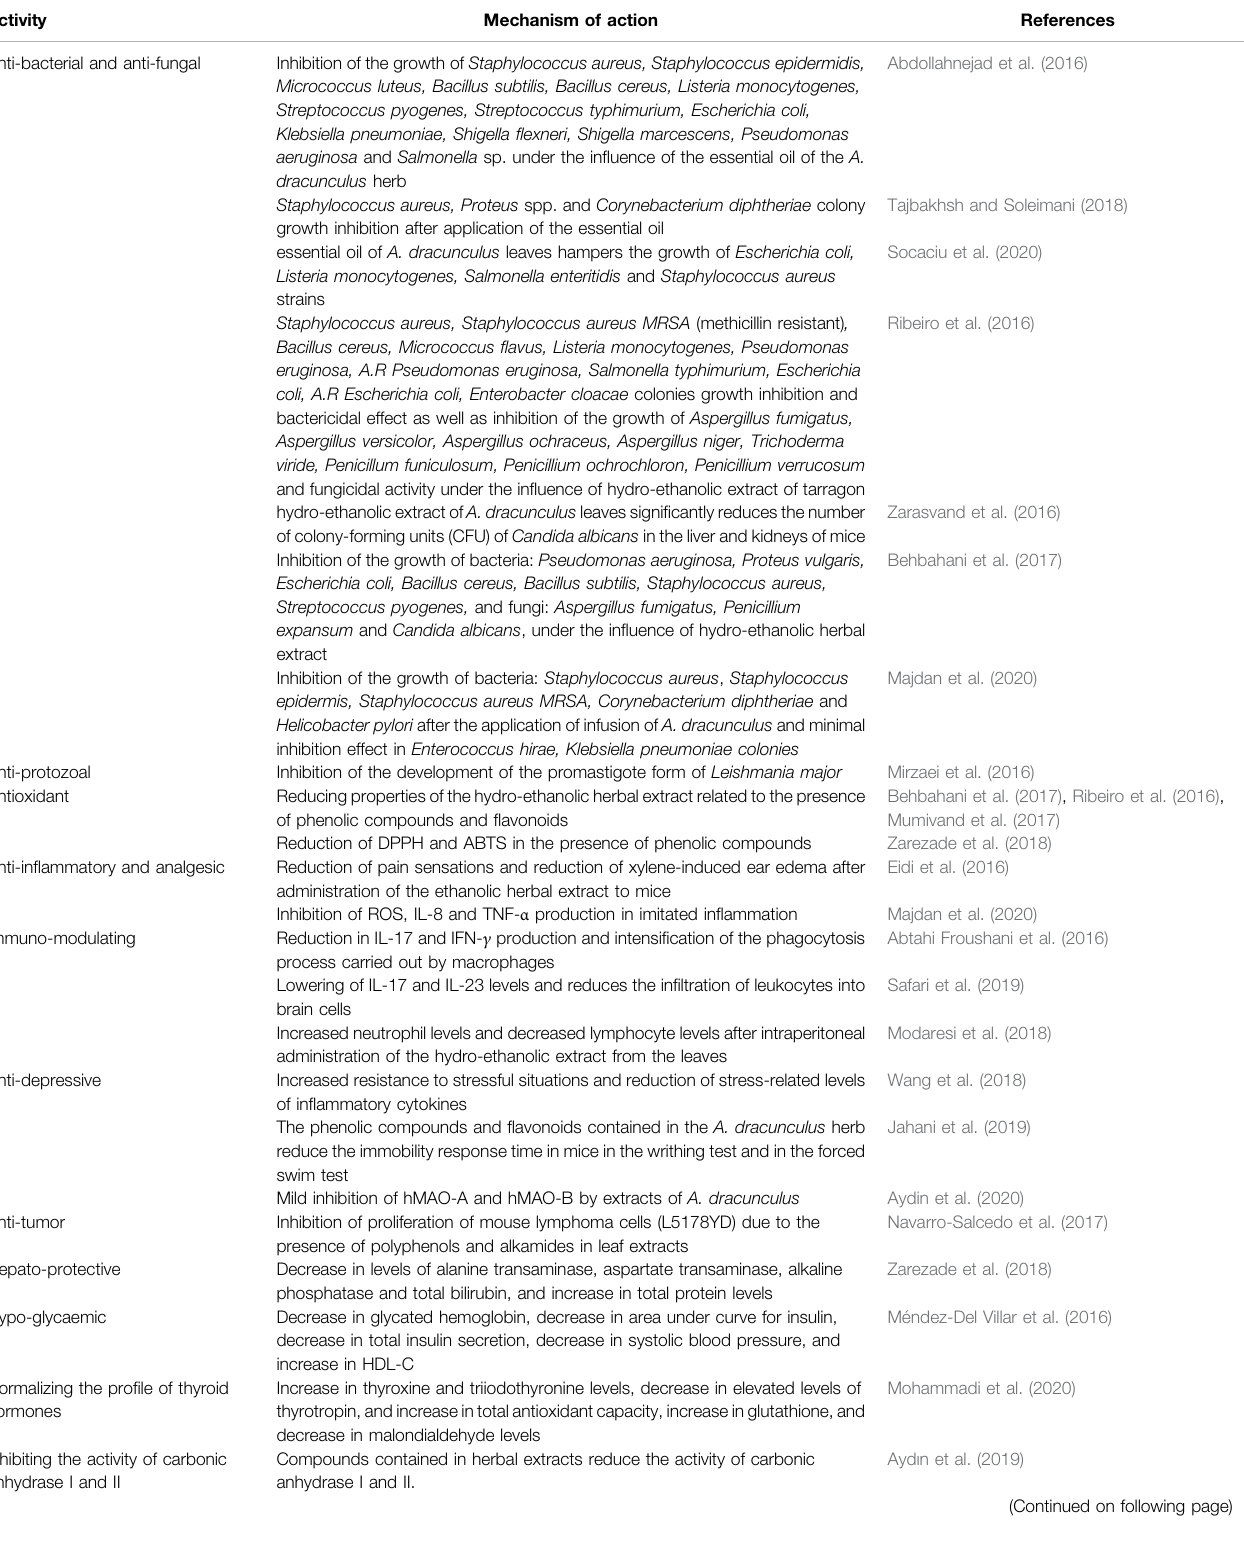
TABLE 3 | Pharmacological properties of A. dracunculus